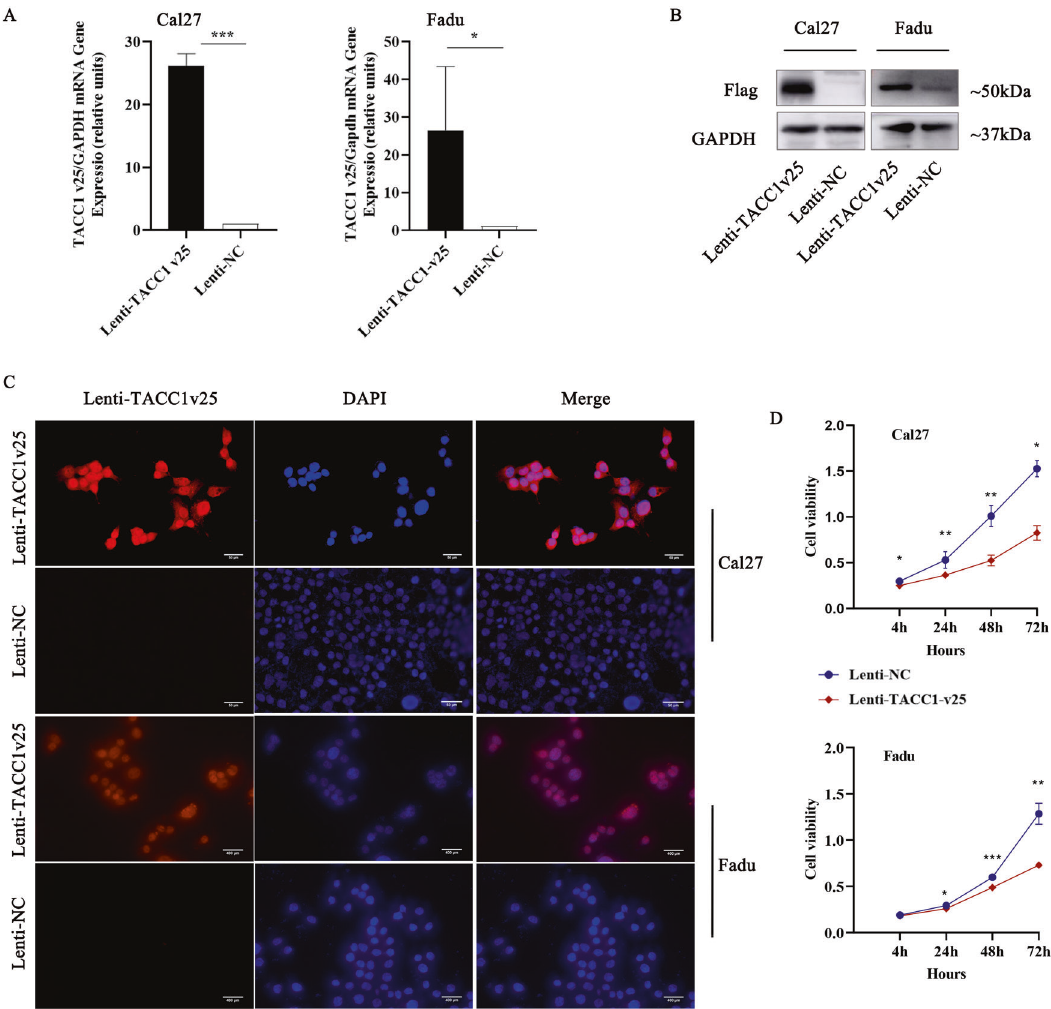
Fig. 3 TACC1v25 inhibits cell proliferation in HNSCC. RT-qPCR ( A ) and western blot ( B ) verifying established Lenti-TACC1v25-Cal27/-Fadu cells. C Subcellular localization of ectopic TACC1v25 in Lenti-TACC1v25-Cal27/-Fadu cells (original magni fi cation 400×). TACC1v25 (anti-Flag) was observed not only in the nucleus, but also in perinucleus membranes and cytoplasm by IF. D Effect of TACC1v25 on proliferation as determined by CCK8 assay. Cell proliferation was inhibited in Lenti-TACC1v25-Cal27/Fadu cells compared to NC group. * P < 0.05, ** P < 0.01, *** P <